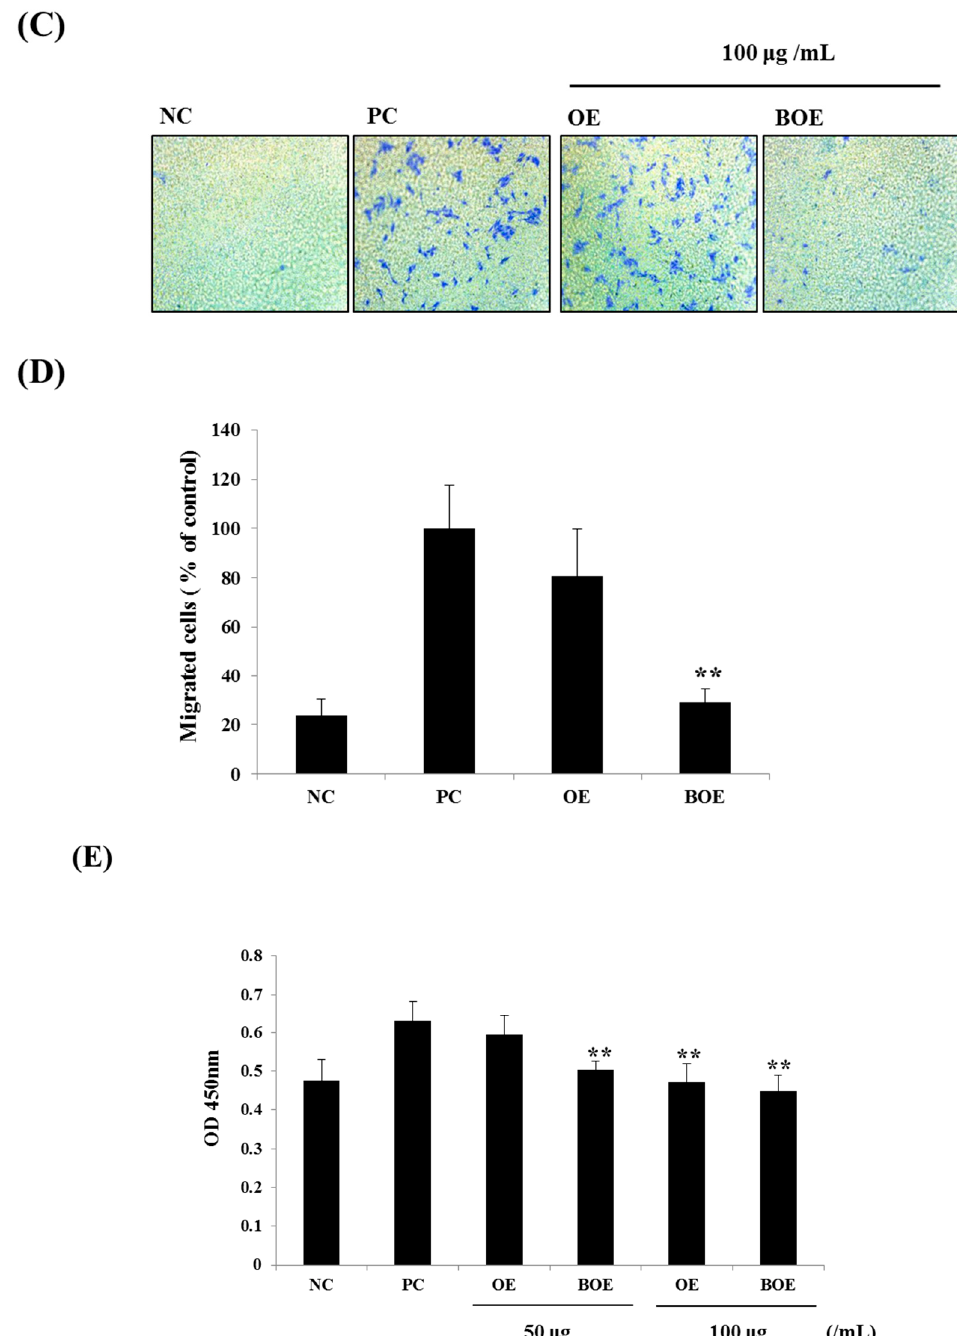
Figure 2. Effects of OE and BOE on cell migration and adhesion abilities of Ms-1 cells. ( A ) Cells were scratched and treated with the indicated concentrations of OE or BOE. The control (Con) was treated with the same amount of DMSO. Representative images were photographed under a microscope at 100× magnification. Dased lines indicate the wound edge on the right and left side of the scratch. ( B ) The wound closure area was quantified by ImageJ software (National Institute of Health, Bethesda, MD, USA). ( C ) Cells were pretreated with OE or BOE, and numbers of migrated cells were quantified ( D ) using ImageJ software. The cells were counted in three random parts at 200 × magnification. ( E ) Cells were pre-treated with OE or BOE, and the number of adherent cells were measured using CCK-8 solution. BSA (bovine serum albumin)-coated control and FN (fibronectin)-coated control were used as negative control (NC) and positive control (PC), respectively. p < 0.01 (**); p < 0.05 (*). Bars represent mean ± SD of three independent experiments.